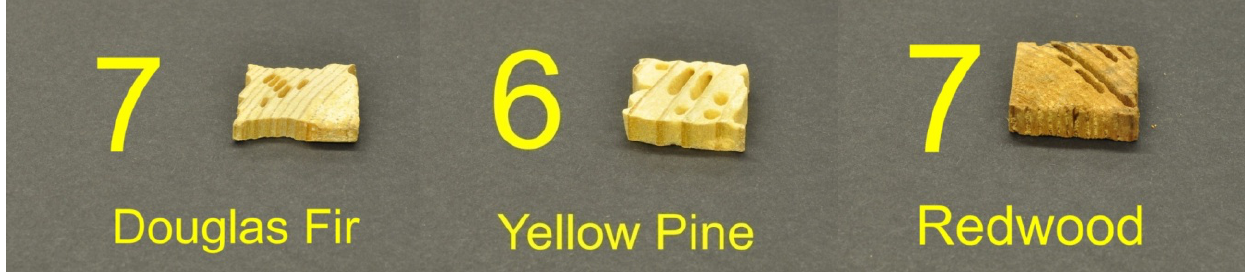
Figure 6. Sample visual ratings for C. gestroi EI Rating: 6 = severe, 30–50% affected; 7 = moderate/severe, 10–30%